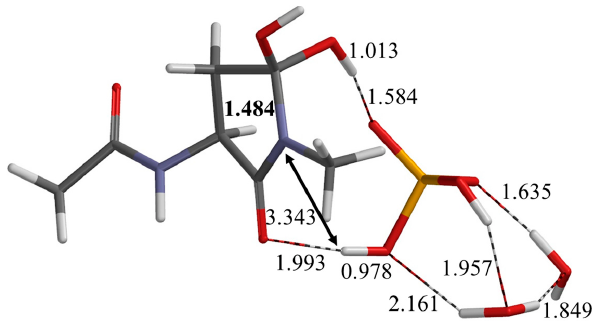
Figure 5. The geometry of the intermediate complex IC1. This complex is directly connected to TS1 (Figure 4). Selected interatomic distances are shown in Å. Grey: carbon; white: hydrogen; blue: nitrogen; red: oxygen; orange: phosphorus.